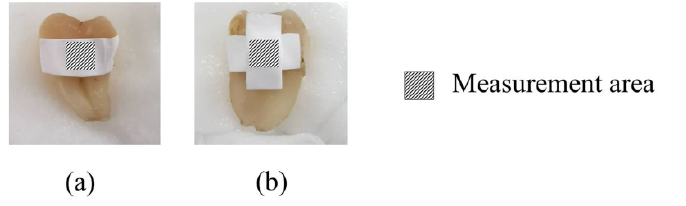
Figure 9. Horizontal placement of the ENFs obtained from P-CP, PP-CP, PS-CP, PPS-CP1, PPS-CP2 ( a ) and horizontal and vertical placements of PPS-CP3 on the tooth surface ( b ).